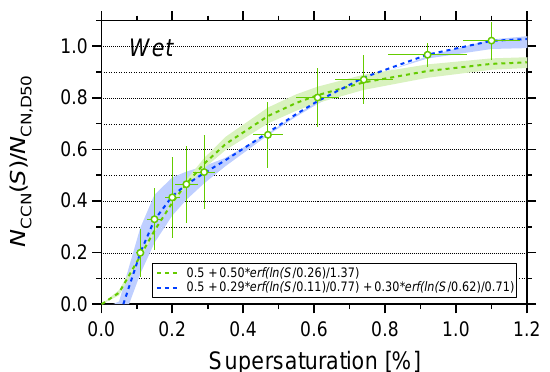
Figure 15. CCN efficiency spectrum for the wet season scenario (Fig. 14b) with N CN,50 as reference concentration. The experimen- tal data have been fitted with single- and double-erf fits (dashed lines with shading as uncertainty of the fits). The error bars at the markers represent the measurement error in S and 1 standard devi- ation in N CCN ( S)/N CN,50